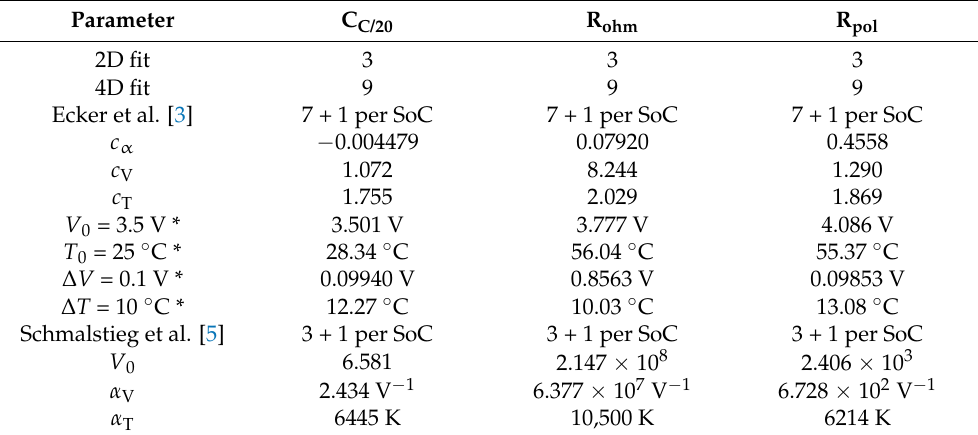
Table 5. Comparison of the number of parameters and additional parameters needed for each SoC at which the aging is to be evaluated. Comparison of the obtained values for the